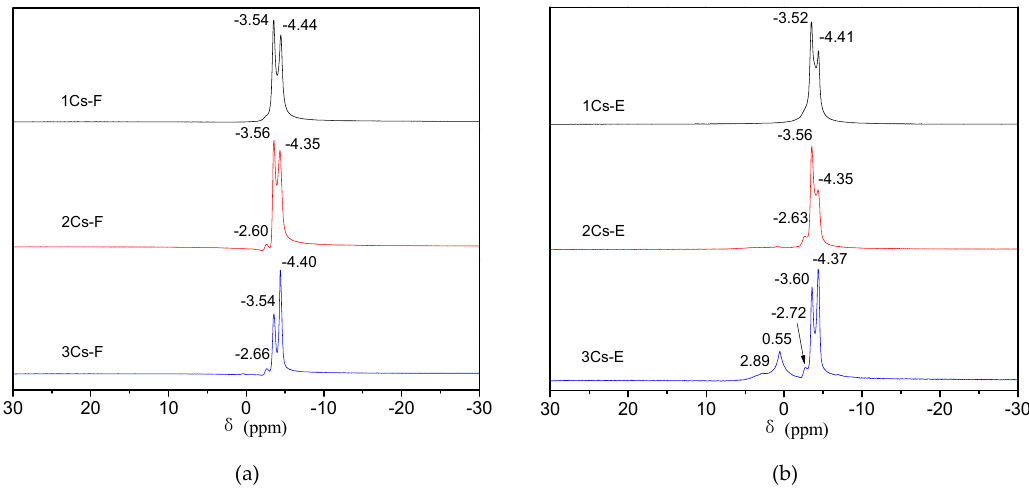
Figure 2. 31 P magic angle spinning nuclear magnetic resonance (MAS NMR) spectra of ( a ) the initial precipitates and ( b ) the evaporation residues.